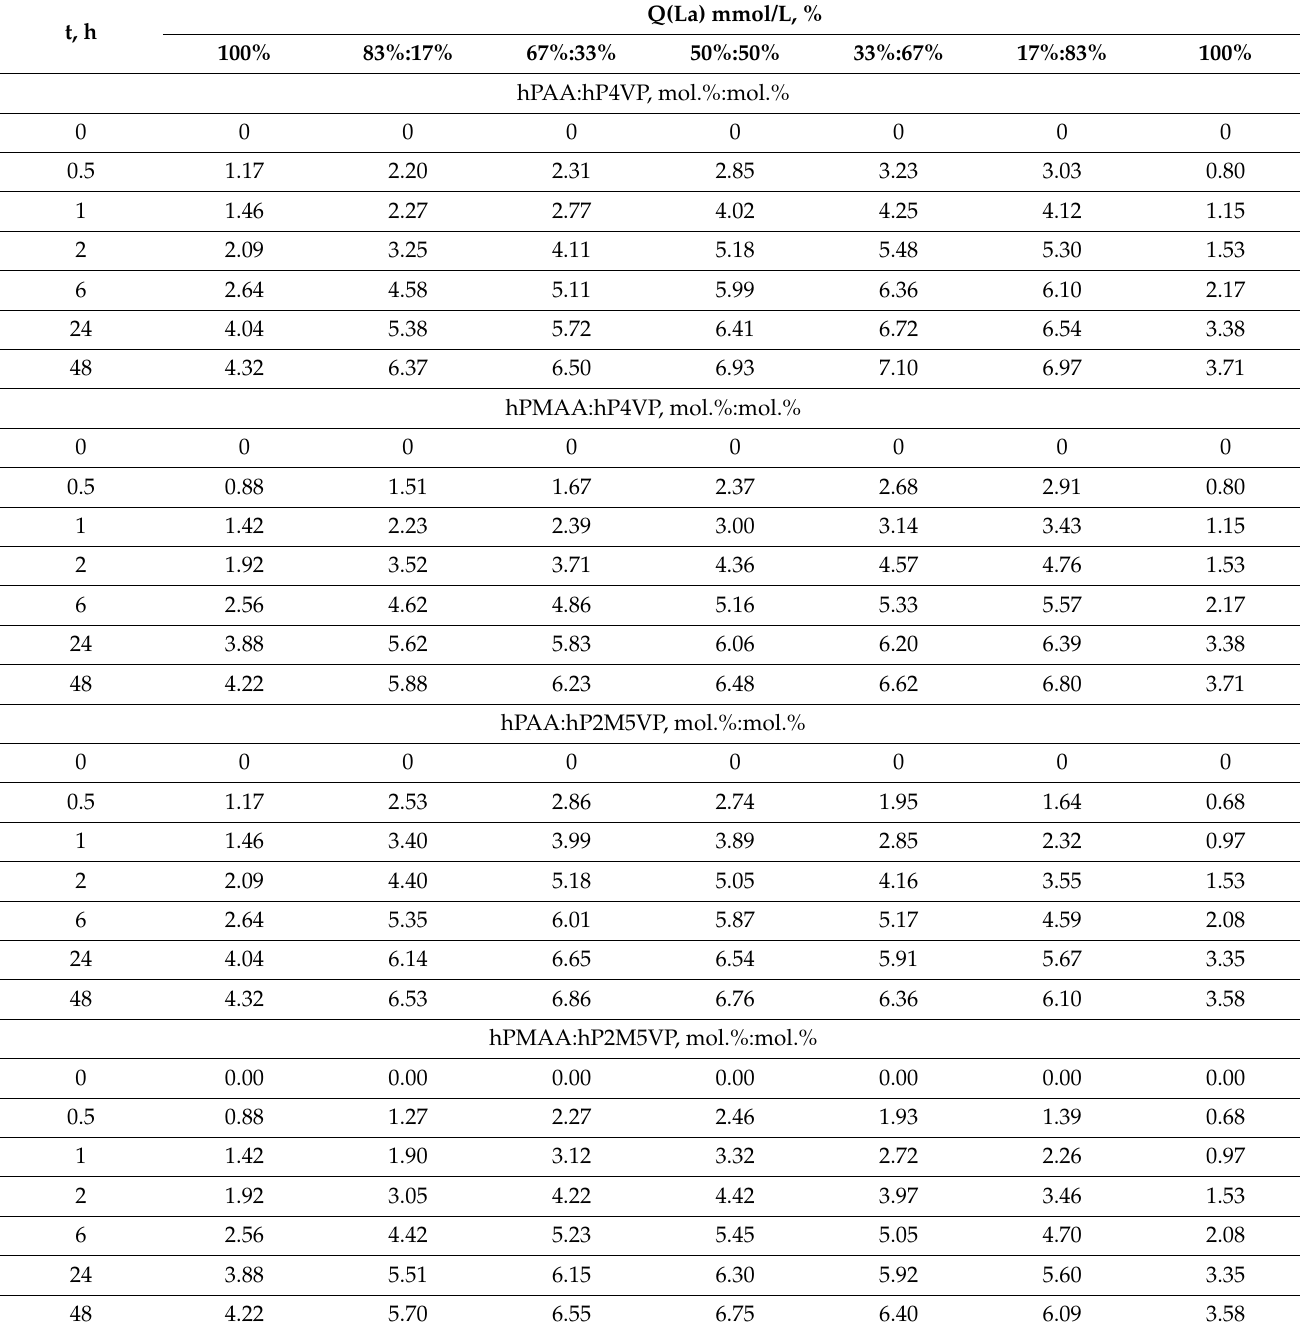
Table 2. Dynamic exchange capacity (in relation to lanthanum) of the interpolymer